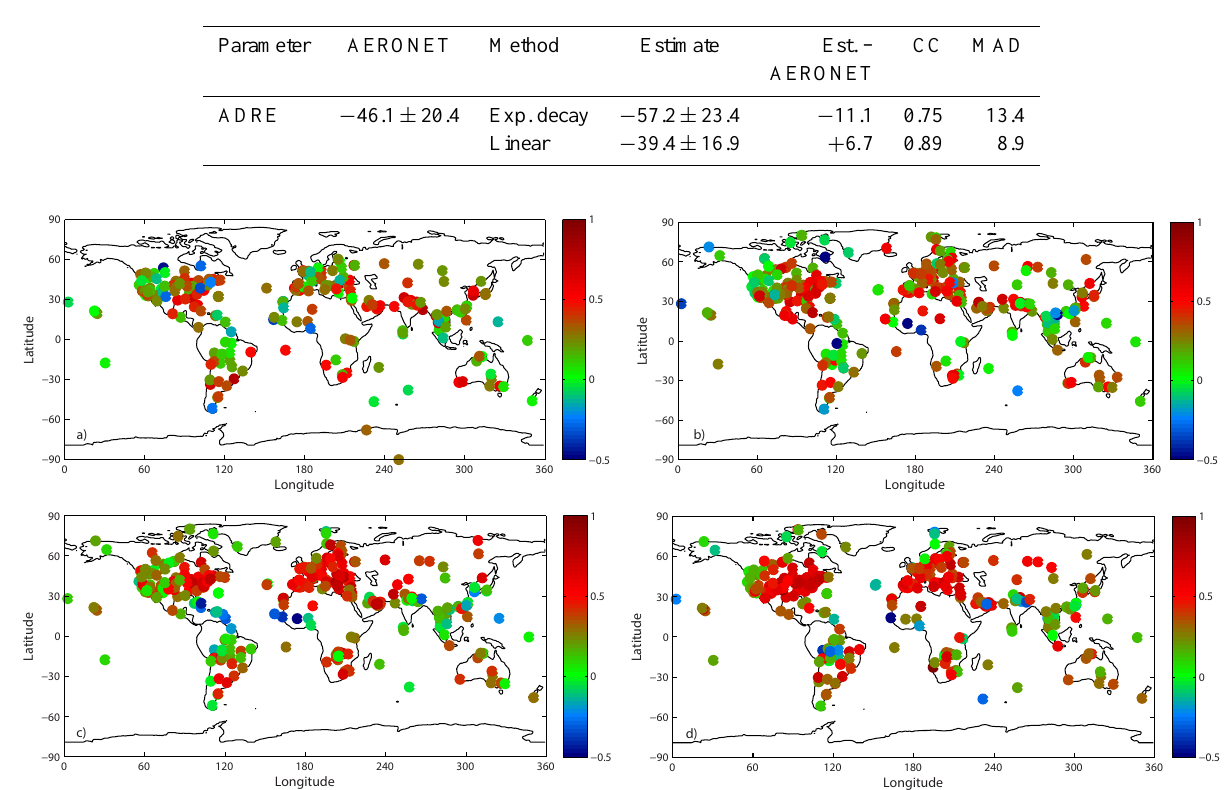
Table 1. The estimated ADRE ( F aer ) with standard deviations compared with the AERONET value. MAD – mean absolute deviation. Units are in Wm − 2 , except for the correlation coefficient (CC).